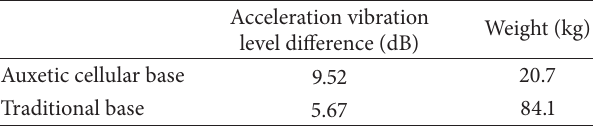
isolation systems: single-stage system, two-stage system, and floating raft isolation system. The stability and the vibration